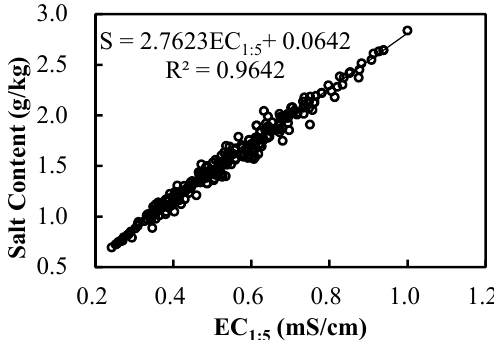
Figure 4. Relationship between soil salt concentration and soil EC 1:5 .